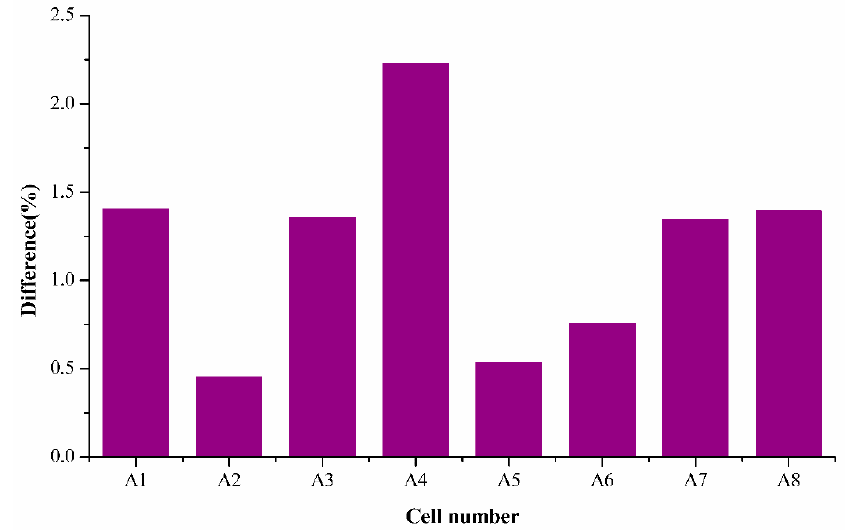
Figure 5. Comparison result between the estimated and experimental results for the ECBE model verification for each cell after the completion of the test (Cell A1, A2 are tested for 500 cycles, A3,